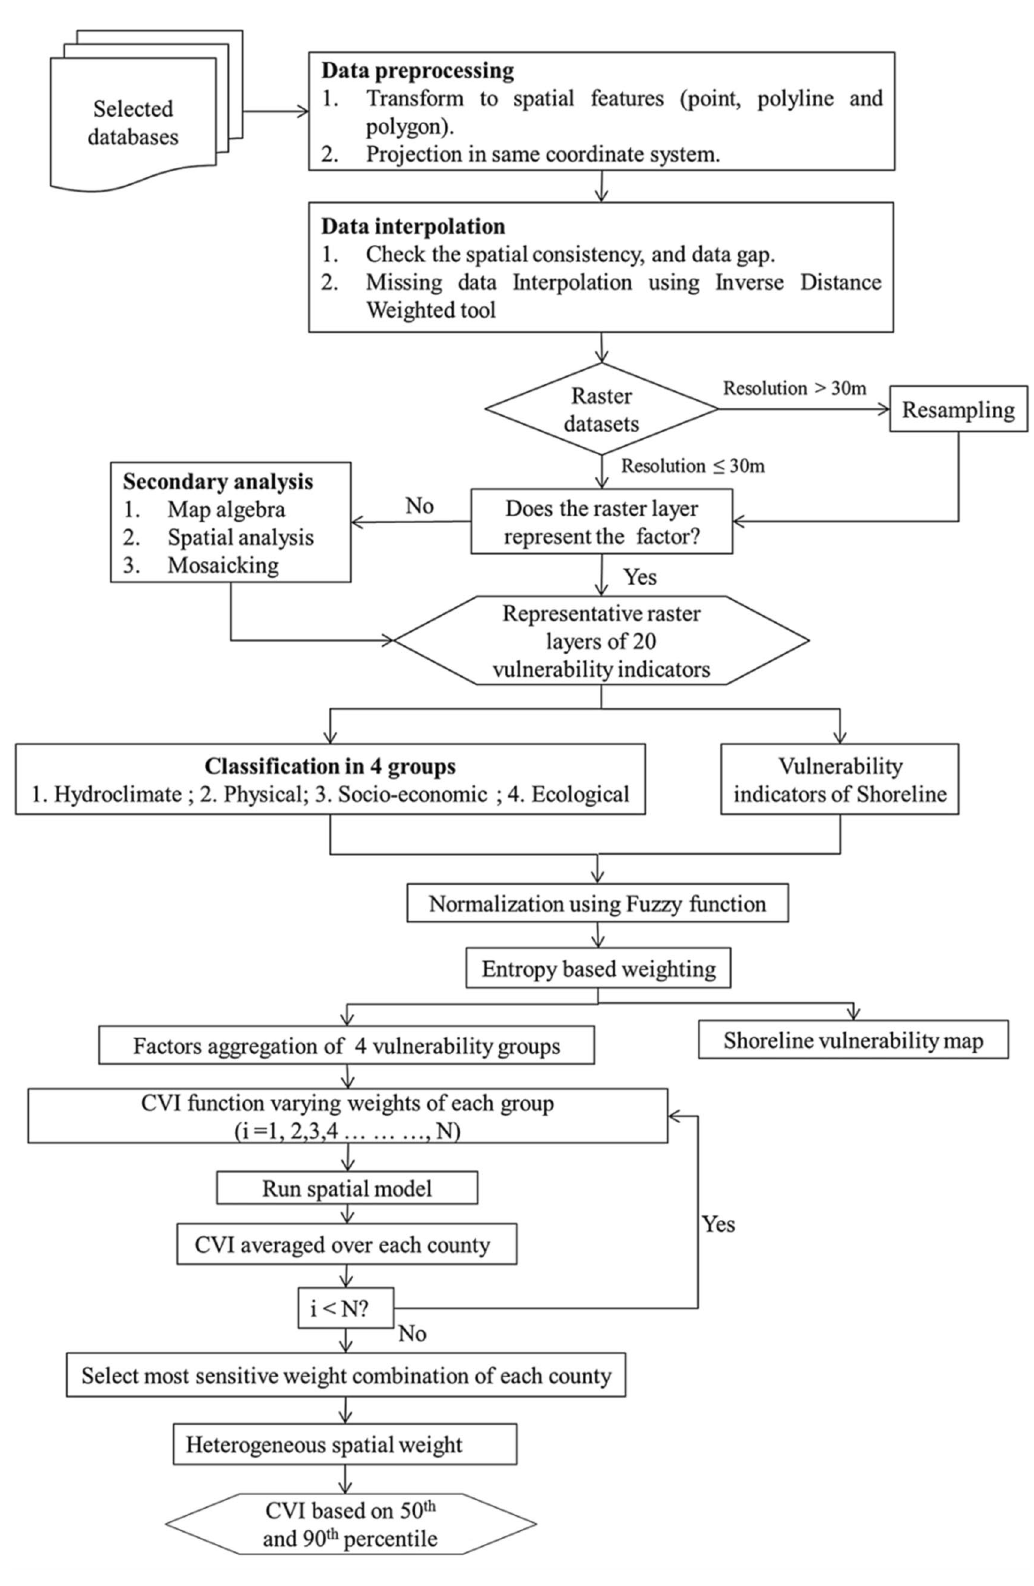
Figure 1. Schematic of the MCDM framework for integrated coastal vulnerability